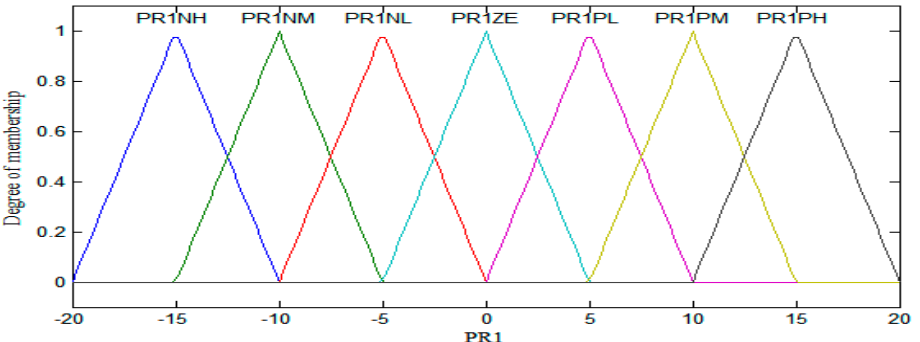
Figure 5. Temperature fuzzy controller outputs.